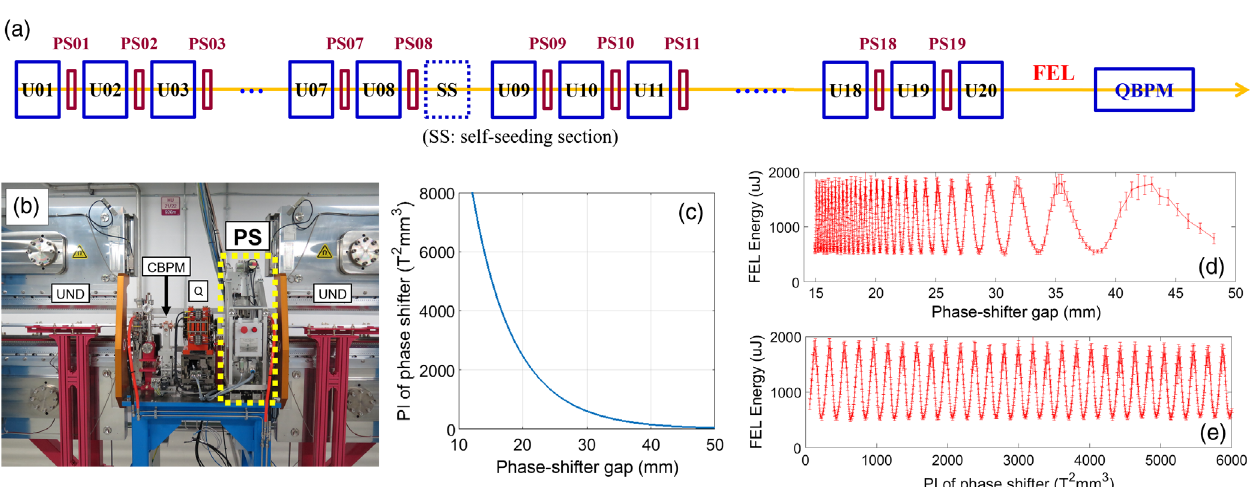
FIG. 3. (a) Schematic layout of the hard x-ray undulator line at PAL-XFEL. (b) Intersection between undulator (UND) modules consisting of cavity beam position monitor (CBPM), quadrupole (Q), and phase shifter (PS). (c) Measured phase integral of the phase shifter as a function of the gap. Measured FEL intensity as a function of (d) the gap of the phase shifter and (e) the phase integral of the phase